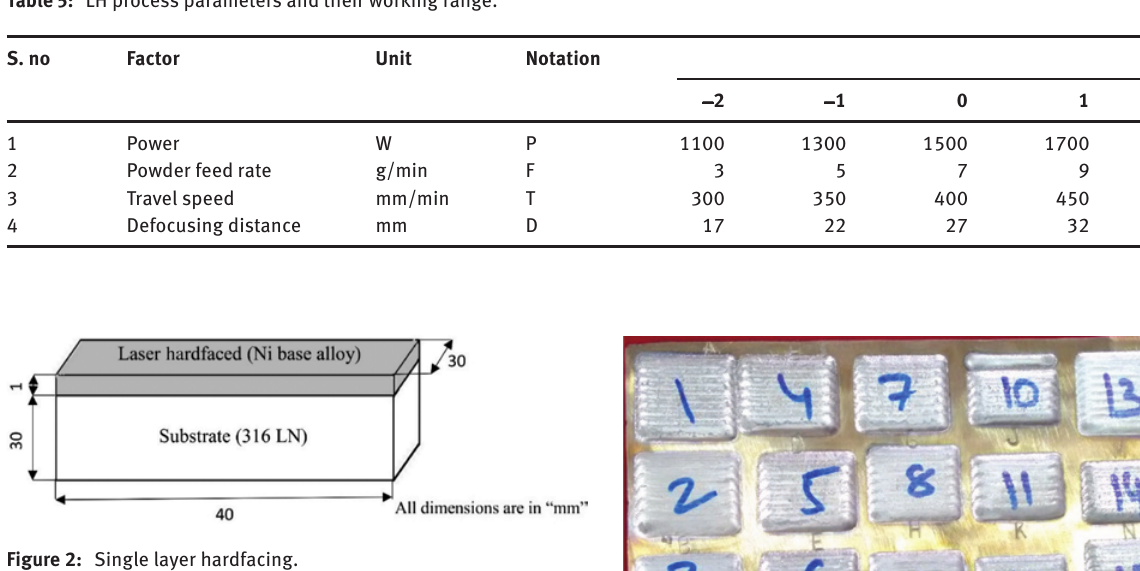
Figure 2: Single layer hardfacing.